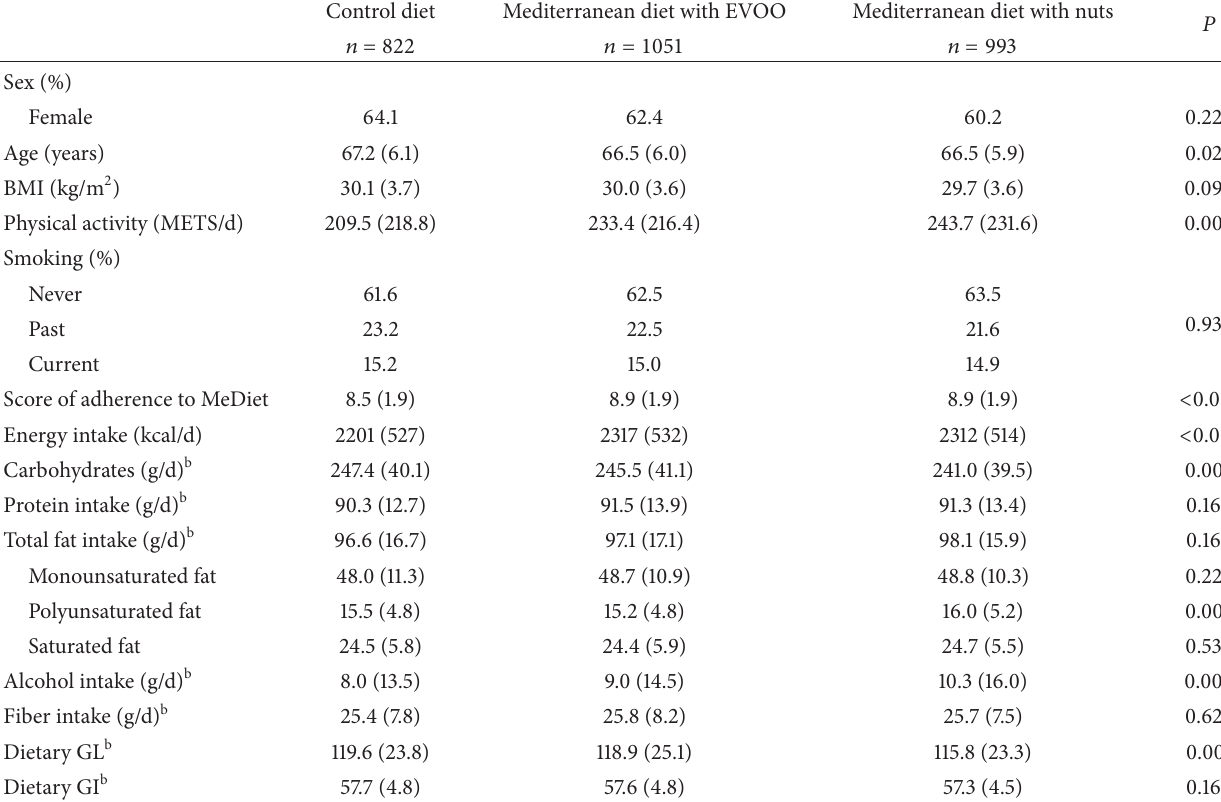
Table 1: Baseline characteristics of participants according to the intervention group in the PREDIMED study a